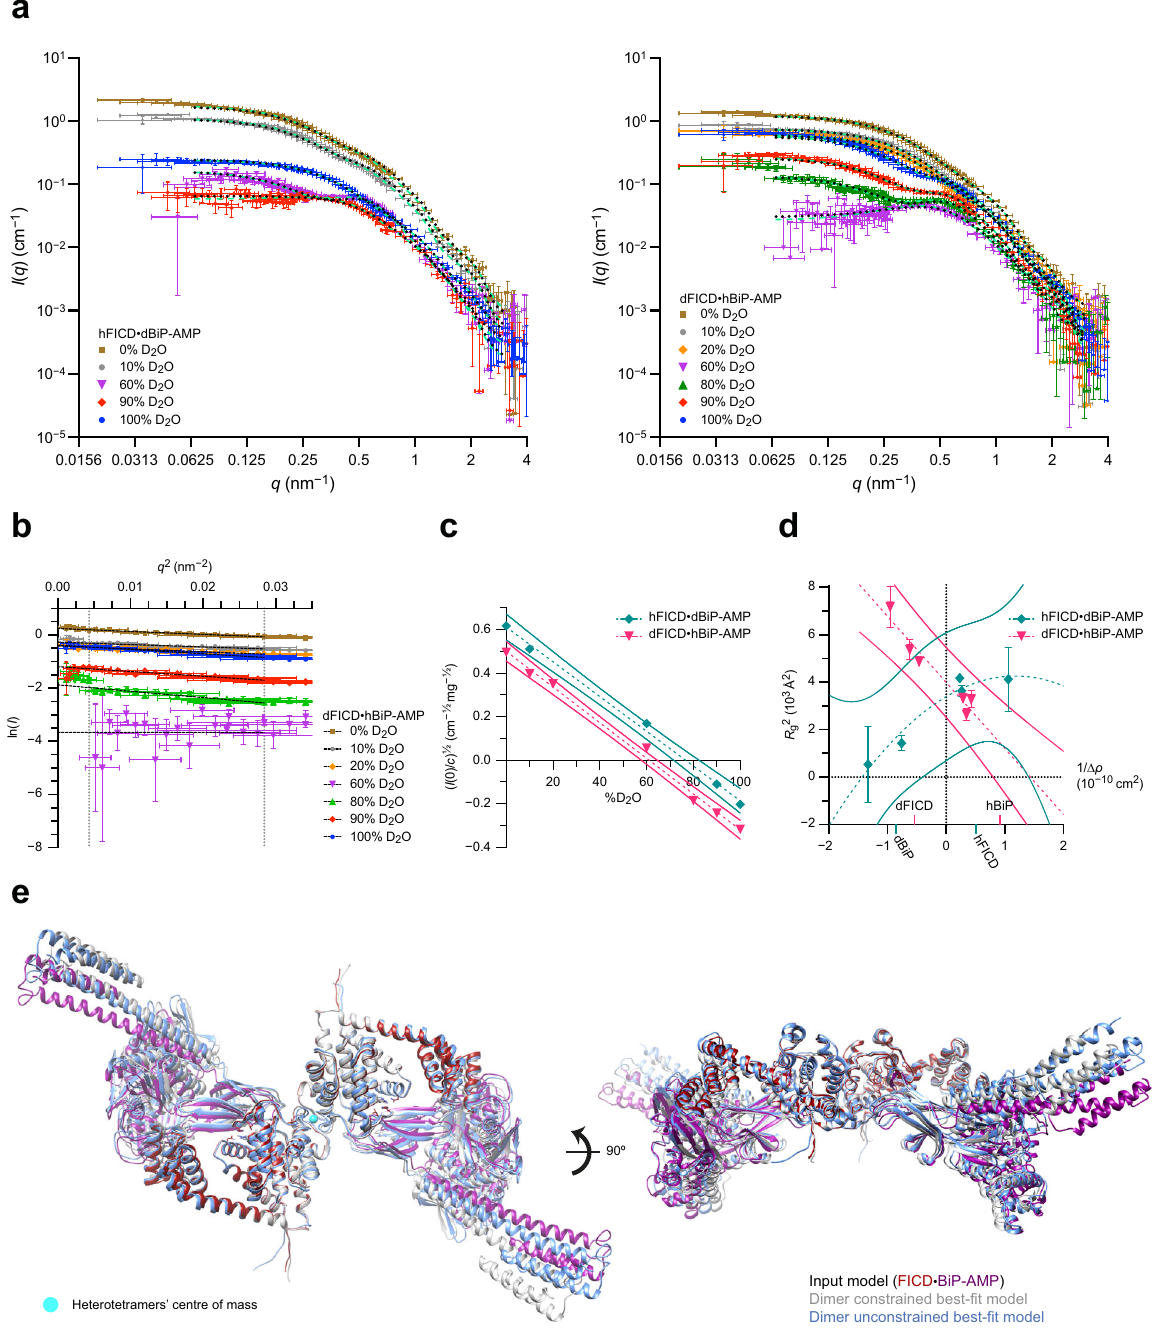
Fig. 2 The DeAMPylation complex probed by small-angle neutron scattering (SANS). a Contrast-variation SANS curves of copuri fi ed dimeric FICD and full-length AMPylated BiP. Overlaid dotted black lines are theoretical scattering curves based on the modelled heterotetramer shown in Fig. 1c, dashed green lines are the theoretical scattering curves from fl ex- fi tting of the input heterotetramer model to each scattering curve individually (with a constrained FICD dimer interface) (see Supplementary Fig. 3b – e). In each experiment ‘ d ’ and ‘ h ’ refers to the partially deuterated and non-deuterated components, respectively. Mean values are shown alongside error bars representing the standard error of the mean (SEM) calculated with respect to the number of pixels used in the radial data averaging. b Guinier plot of partially deuterated FICD and non-deuterated AMPylated BiP (derived from the scattering data shown in a , with mean ± SEM values plotted). Vertical, grey dotted lines represent the q -range for fi tting the linear best- fi t curves (black dashed lines) (see Supplementary Fig. 3a). c Scattering amplitude plots. Linear best- fi ts are shown with dashed lines and 95% con fi dence interval bands are shown with colour-matched solid lines. d Stuhrmann plot with best- fi t dashed curves. 95% con fi dence prediction bands are shown with solid lines. The determined match points of the individual complex components are indicated on the x -axis. In c and d best- fi t values are shown alongside the standard errors of the Guinier fi t parameters. e Optimal fl ex- fi t structures with respect to overall agreement of theoretical scattering to all experimental contrast-variation SANS datasets. Output structures are aligned to the input heterotetramer model, itself derived by imposing the C2 symmetry of the FICD dimer (PDB 4U0U) 24 onto the heterodimeric deAMPylation complex crystal structure as in Fig. 1c. See Supplementary Movie 1. Source data are provided as a Source Data fi